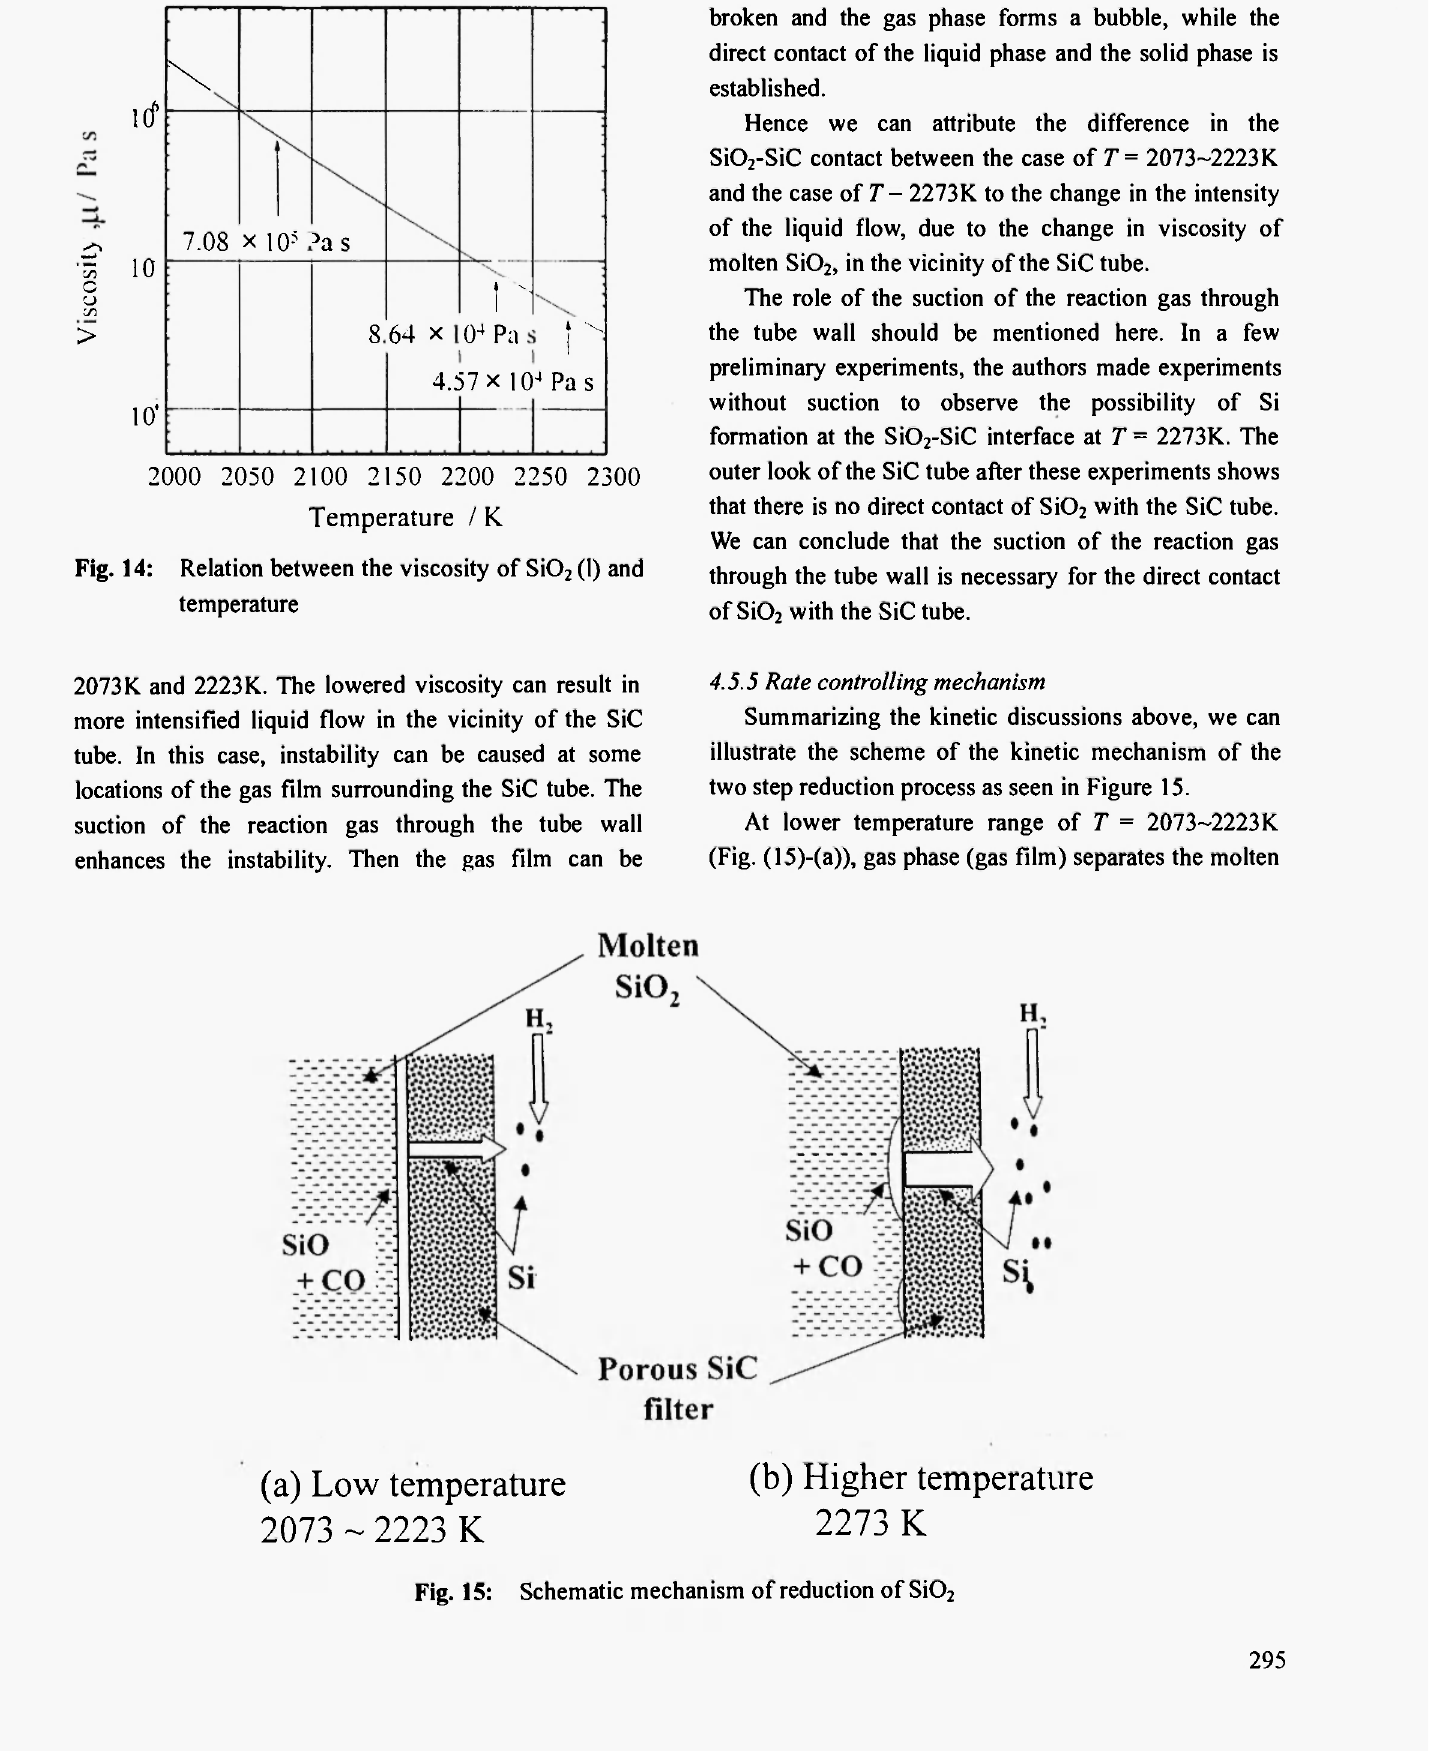
Fig. 15: Schematic mechanism of reduction of Si0 2